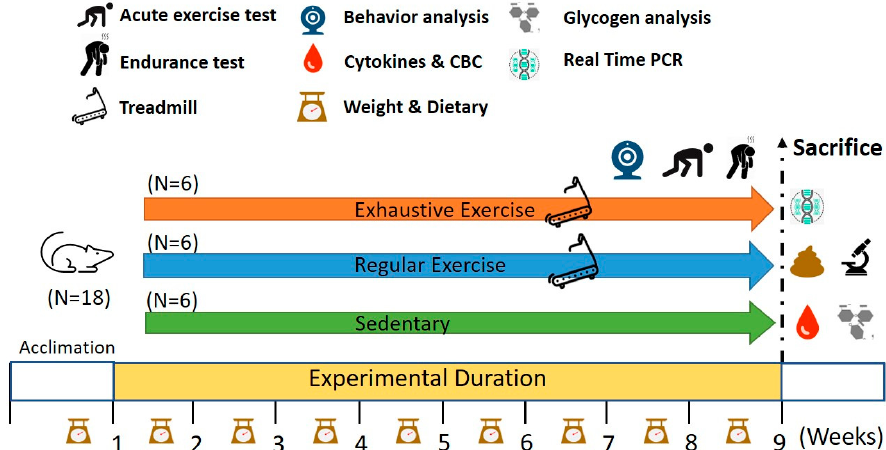
Figure 1. Experimental designs for the effects of regular exercise and exhaustive exercise murine model. The animals were randomly assigned to the indicated three groups (sedentary, regular exer- cise, and exhaustive exercise). The overtraining condition was induced using consecutively exhaus- tive running protocols. The physical fitness and related assessments were analyzed within the test duration and after sacrifice.